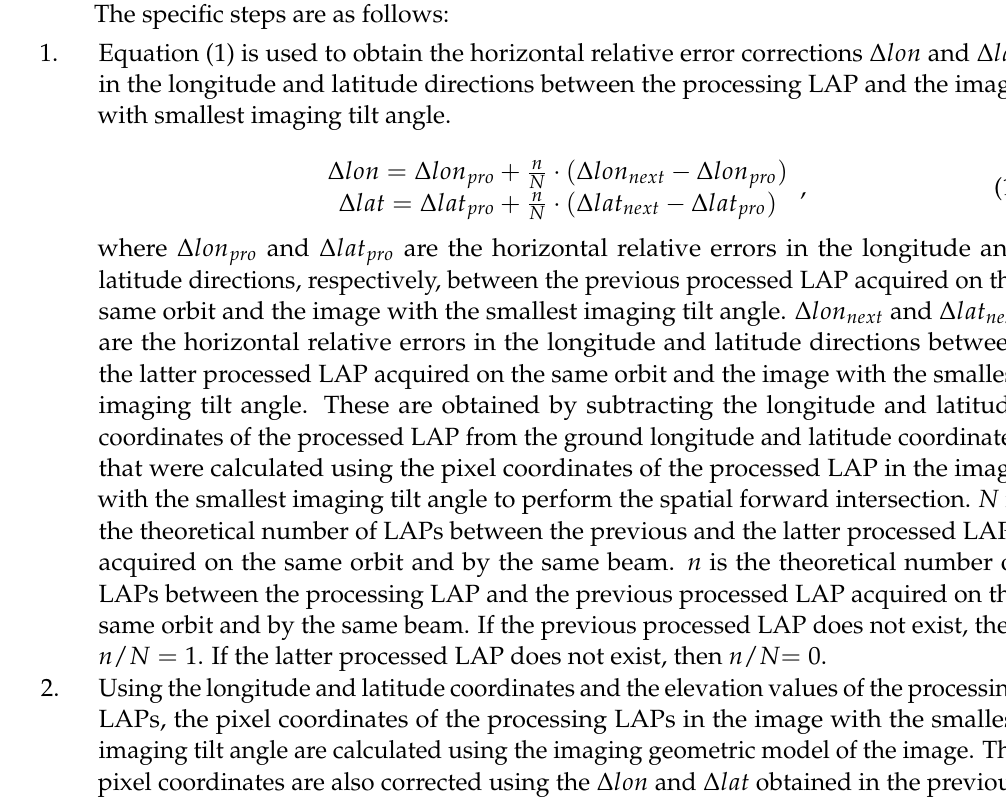
Figure 4. LAP measurement for substituting homonymy points for LAPs.